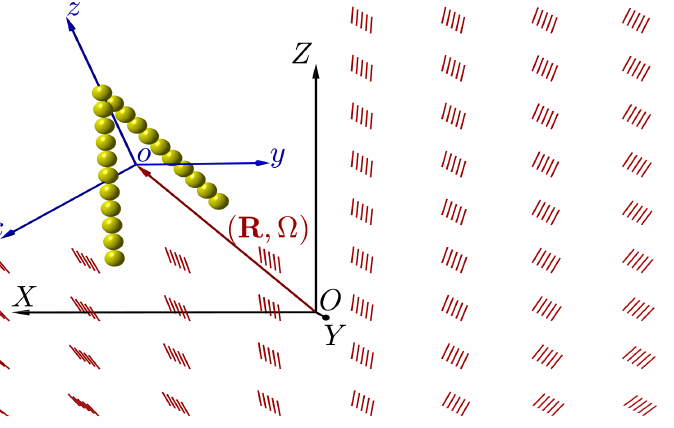
Figure 1. Sketch of the laboratory frame of reference ( OXYZ ) and of the particle frame of reference ( oxyz ) . R is the vector position of the center of mass of the particle in the laboratory frame, and Ω is the set of Euler angles that rotate ( OXYZ ) into ( oxyz ) . The red segments represent the director field with a splay distortion of wavenumber q = 0.05 σ − 1